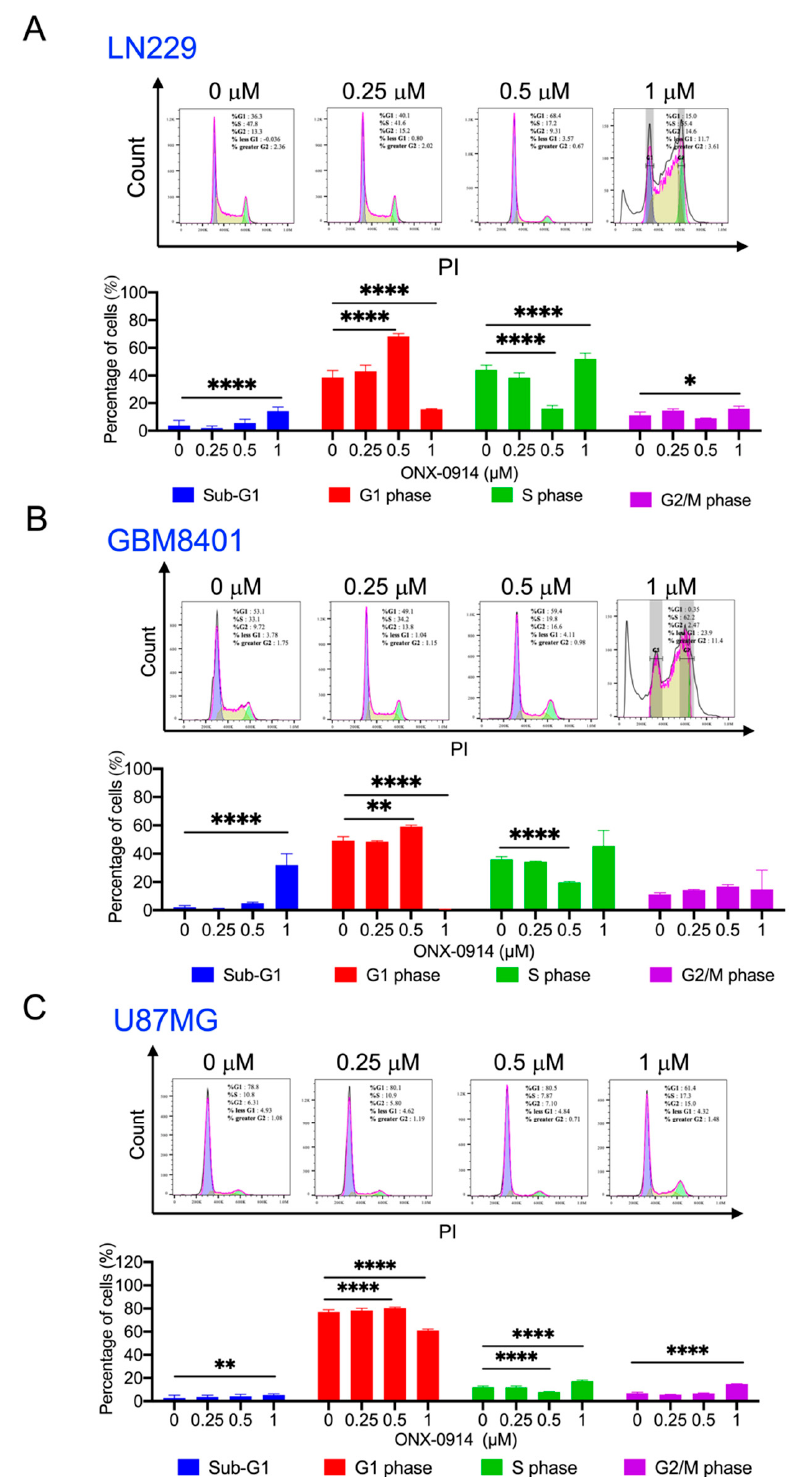
Figure 2. The effect of ONX-0914 on the glioblastoma cell cycle. After ONX-0914 treatment for 24 h, the cells were stained with PI. The percentage of cells in the different phases of the cell cycle is shown in the bar diagram. ( A ) LN229, ( B ) GBM 8401, and ( C ) U87MG cells. *, p < 0.05; **, p < 0.01; ****, p < 0.0001 compared to the control group.